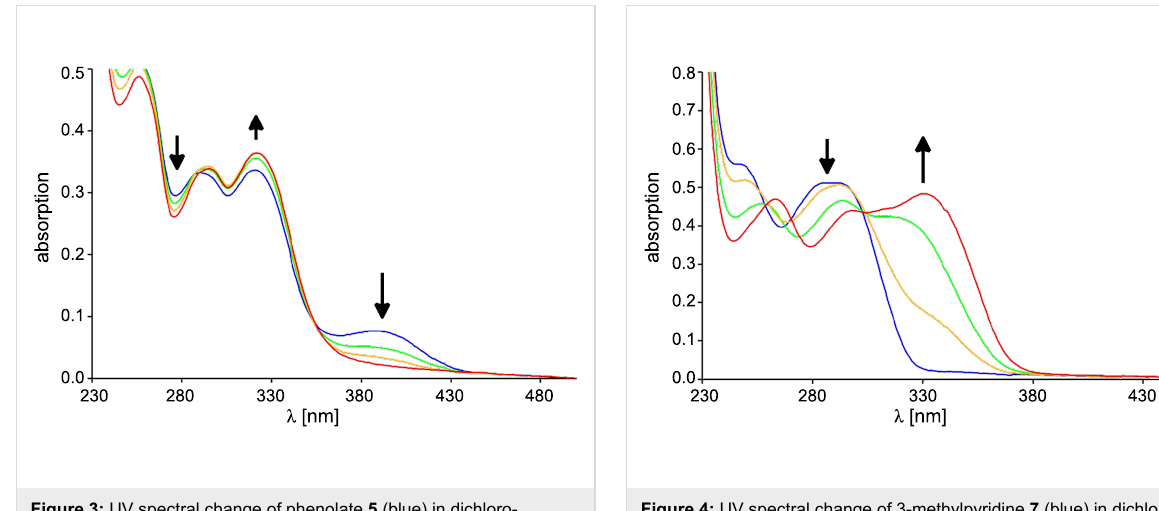
The bathochromic shift during the transition from